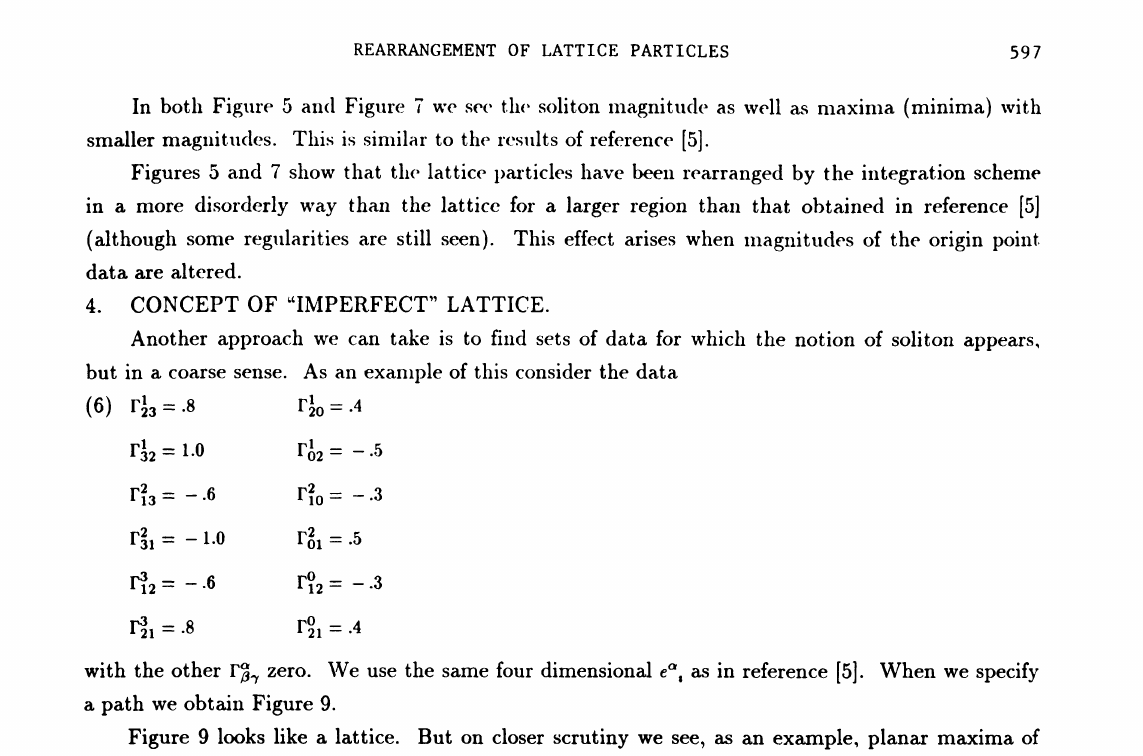
an exple, plan mima